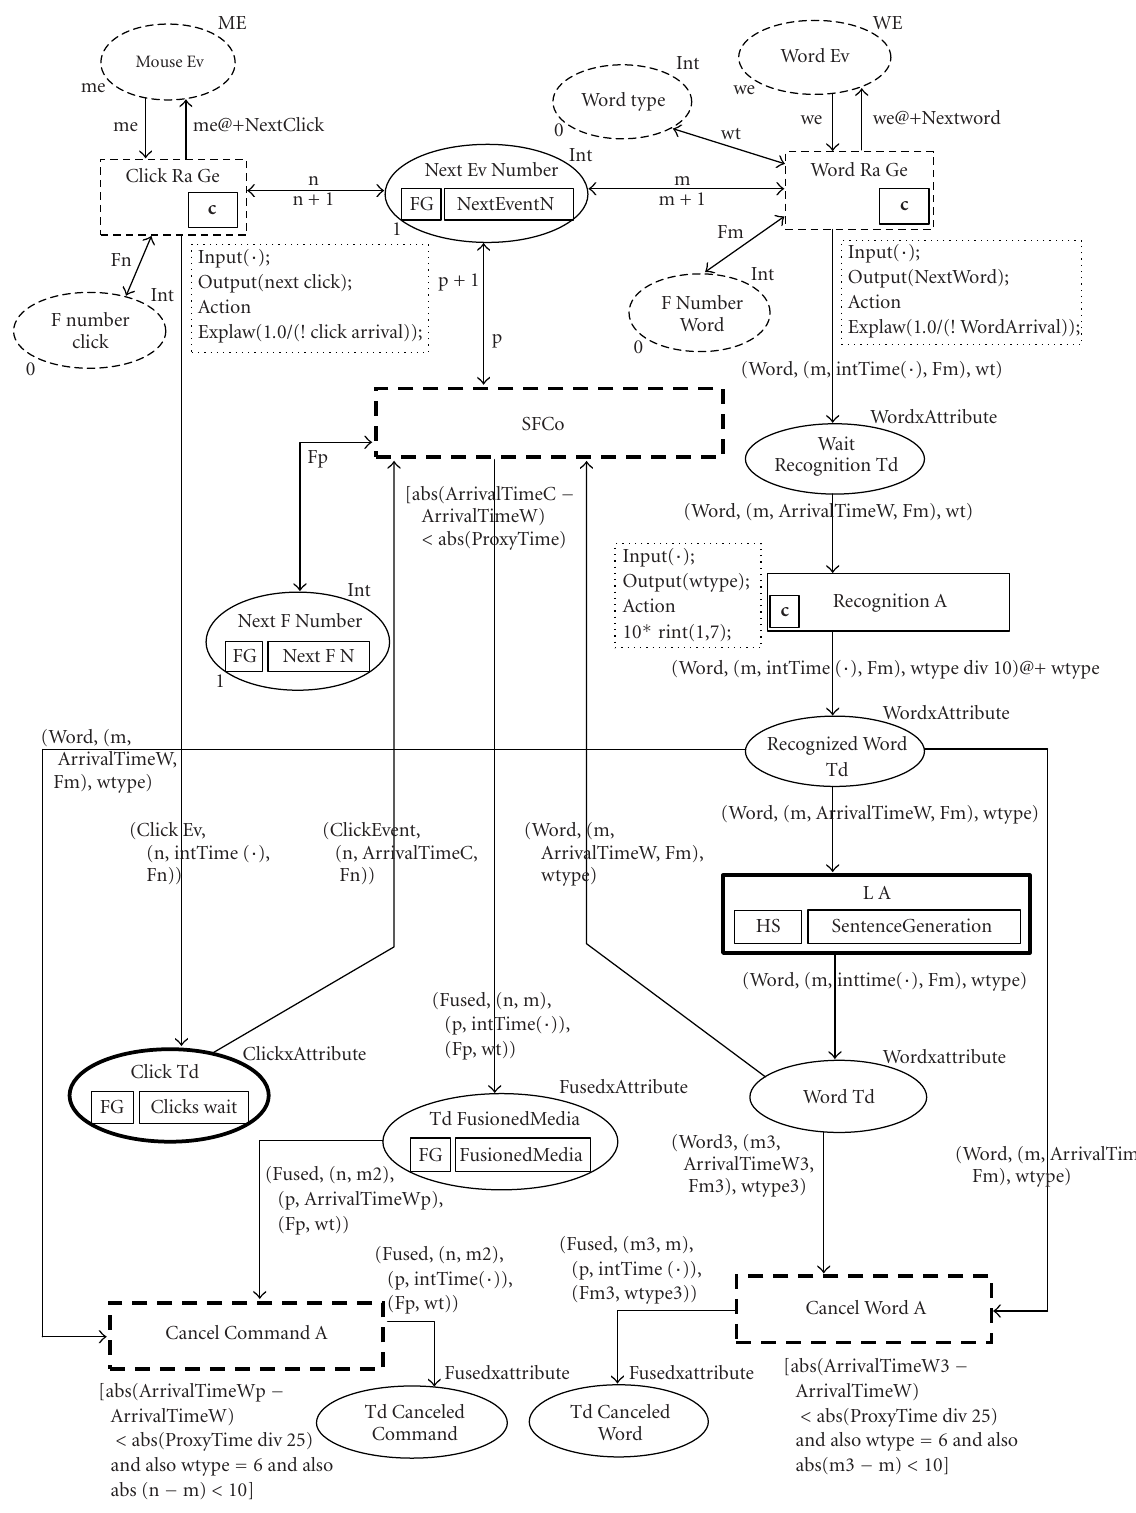
Figure 10: Bimodal fusion dialog. The functions intTime( · ), rint( · ), and Explaw( · ) return current time, discrete uniform, and exponential distribution, respectively (A: agent, Co: component, Ev: event, F: fusion, Ge: generator, L: language, Ra: random, S: semantic, and Td: